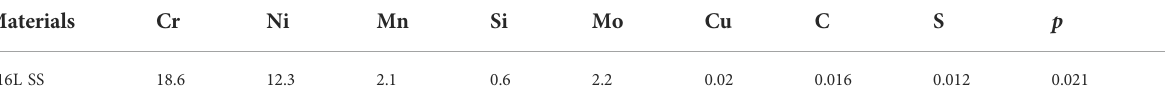
TABLE 2 Chemical compositions of 316 stainless steel (wt.%).